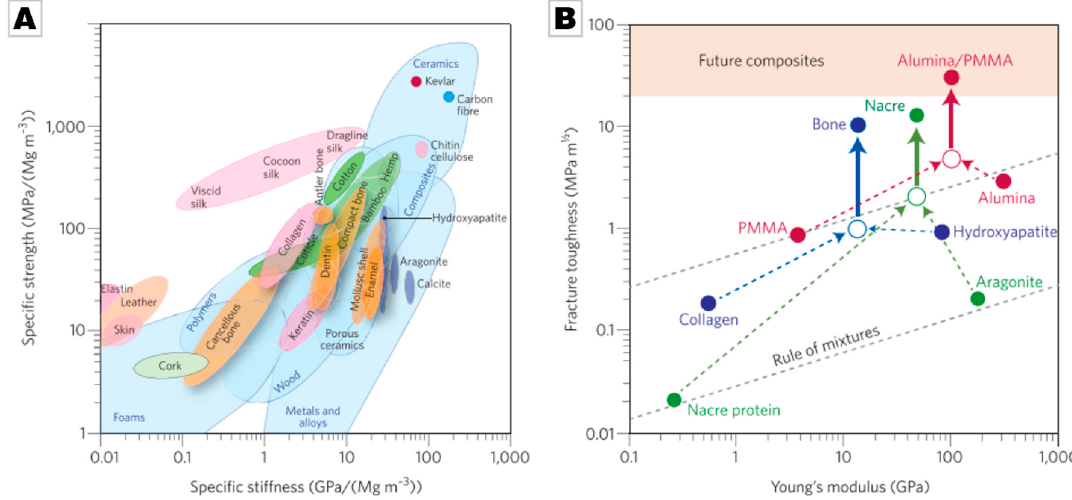
Figure 3. ( A ) Ashby plot, i.e., chart of material properties normalized by density, of natural and synthetic materials. ( B ) Projections for natural and synthetic materials, demonstrating the increase in toughness compared to homogeneous mixtures of their components, i.e., according to the rule of mixtures. By utilizing extensive extrinsic toughening mechanisms, hierarchical materials increase their toughness both for crack growth (closed symbols above the solid arrows) and, albeit to a lesser extent, for crack initiation (open symbols). Adapting these design concepts may lead to synthetic ceramic materials with outstanding properties. For more details, see Wegst et al. [5]. Reprinted by permission from Springer Nature: Nature, Nature Materials, ref. [5], Copyright 2014.